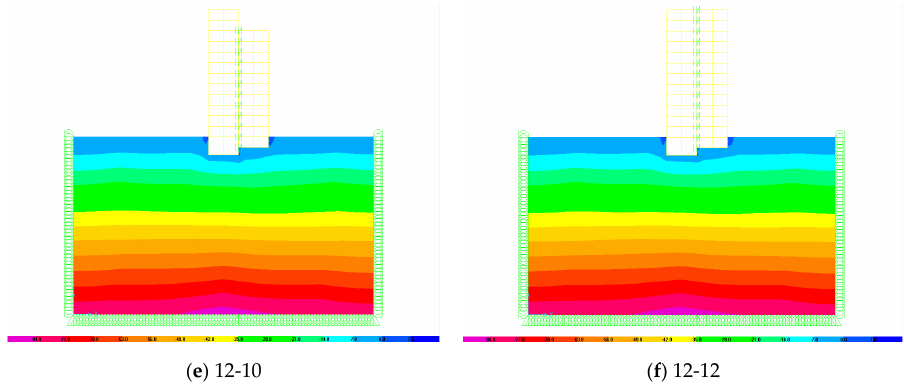
Figure 23. Vertical soil stresses (KN/m 2 ) for the two adjacent buildings with unequal foundation levels.